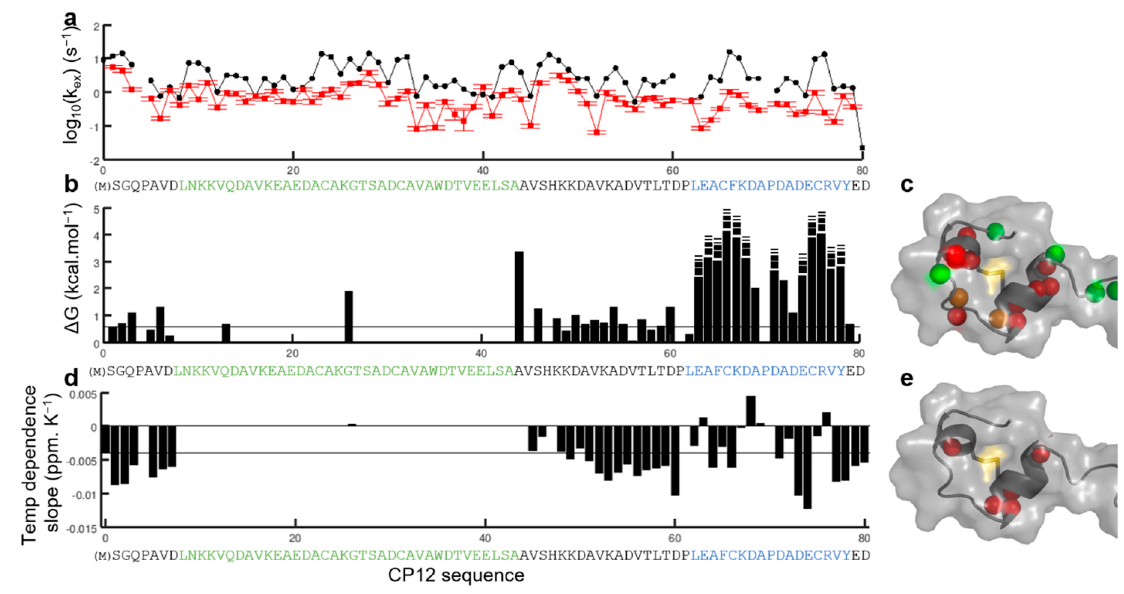
Figure 2. Labile amide protons in CP12 red and CP12 ox . ( a ) Solvent-amine intrinsic proton exchange rates calculated using SPHERE [44] (black) and solvent–amide proton exchange rates measured using CLEANEX-PM experiment [39,43] on CP12 red (red). The similarity between both values indicated that CP12 red is intrinsically disordered. The signal intensity as a function of the spin-lock delay in the CLEANEX-PM experiments is shown in Figure S1. ( b ) Gibbs free energy of CP12 ox backbone amides derived from the measured solvent–amine proton exchange using CLEANEX-PM on CP12 ox versus CP12 red (refer to Material and Methods for details), assuming that the exchange falls into the EX2 regime that is highly probable at this low pH (7). The measured rates of exchange for CP12 ox amide at pH 7 and pH 6 are shown Figure S2. In ( b , d ), the stars indicate residues for which the resonances are broadened beyond detection in CP12 ox [31], and the disulfide bridges are indicated above the sequence. ( d ) Value of the slope of the temperature dependence of the proton chemical shift for CP12 ox residues. The line at − 4.6 ppm K − 1 indicates the threshold below which the data indicate the absence of a hydrogen bond [50]. The temperature dependence curves of the chemical shift of the amine proton for all CP12 ox residues are shown Figure S4. ( c ) Structure of the stable C-terminal helical turn with the amide protons protected from the exchange with water highlighted in red, and those exposed to exchange in green. ( e ) On the same structure, the amide protons for which the temperature dependence of the chemical shift has a positive slope are highlighted in red. The CP12 sequence is indicated below the graphs, with the following color coding: the residues that fold in the stable helical turn in the C-terminal region of CP12 ox are in blue, and the residues that undergo chemical exchange in CP12 ox are in green [31].